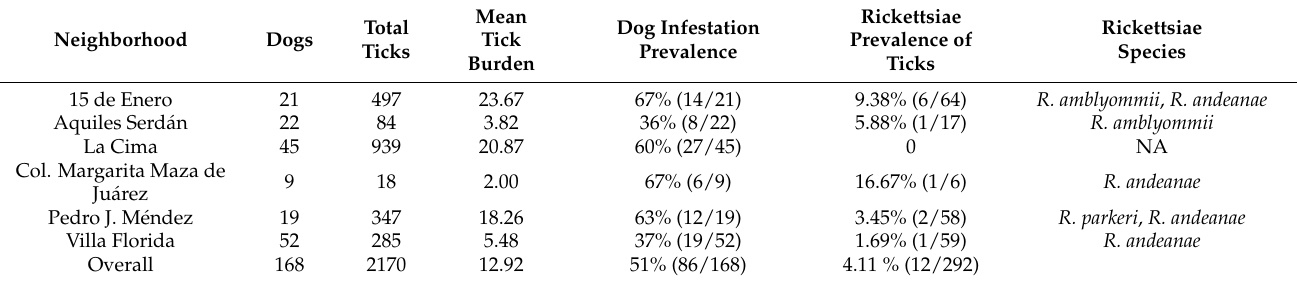
Table 2. A collection summary of each neighborhood sampled in Reynosa, northeastern M é xico. The table indicates all dogs enrolled in the study, their total ticks removed, the average tick burden, the dogs tick infestation prevalence, the rickettsiae prevalence, and the Rickettsia spp. amplified from ticks removed from each of the six neighborhoods. Overall metrics are also